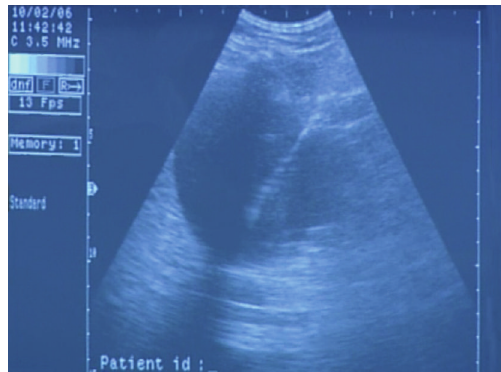
Figure 2: CRS-catheter is introduced until reached the opposite wall of the cyst cavity under ultrasound